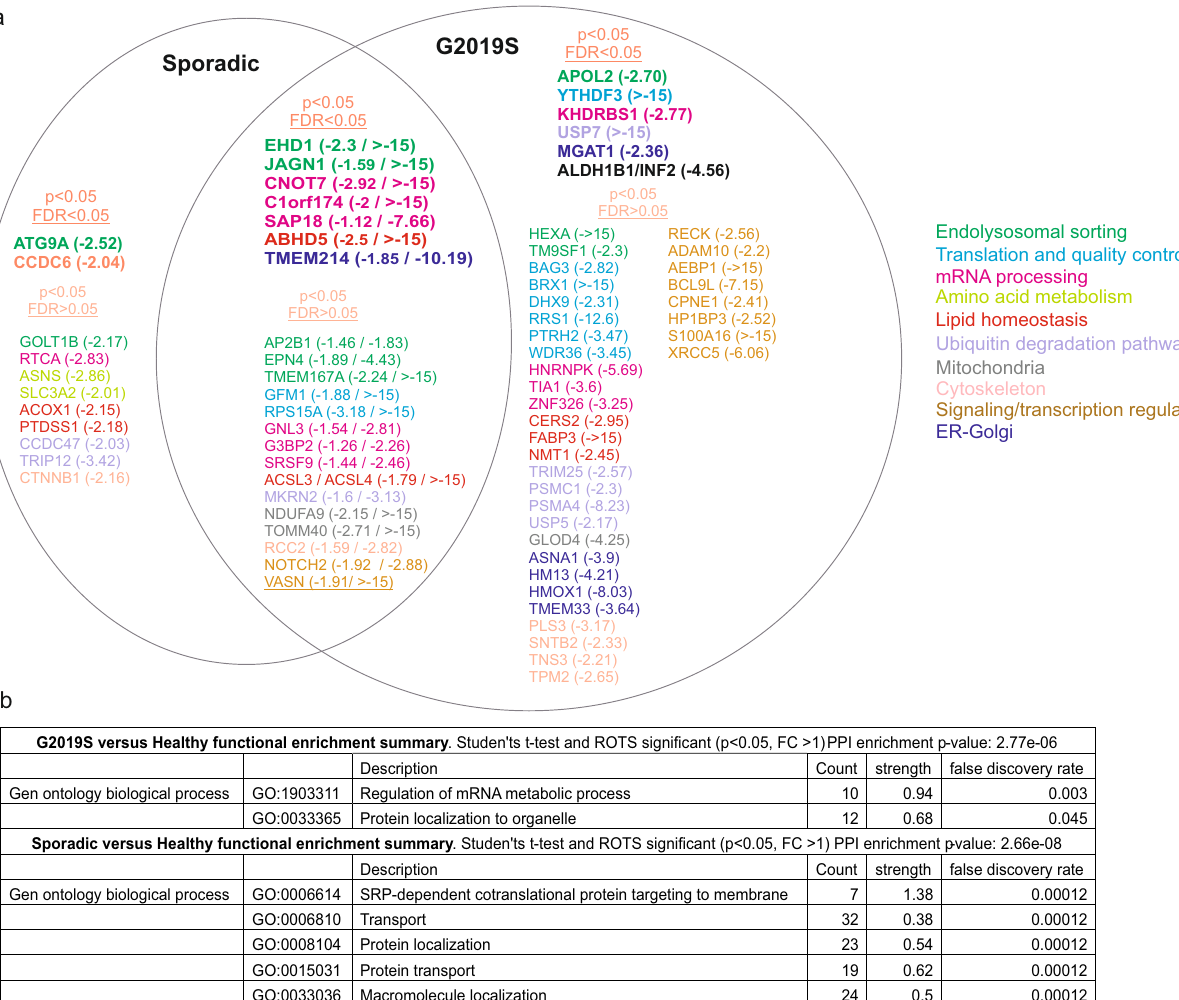
Fig. 5 A. Venn diagram summary of proteins that show reduced homeostasis in LRRK2-G2019S and sporadic PD patients. a Proteins (indicated by gene names) are grouped according to signi fi cance. For each group comparison, proteins that have a fold change >1.5 and a P < 0.05 and FDR < 0.05 in either ROTS or t -test are shown in a separate category to proteins with p < 0.05 but FDR > 0.05 in either test. Proteins plotted in the overlap region are signi fi cantly changing in both sporadic and LRRK2-G2019S groups, where FDR < 0.05 in either ROTS or t-test in either group and p -value < 0.05 in the other group. b STRING enrichment analysis of the proteins shown in a . according to LRRK2-G2019S and sporadic patient groups. Functional enrichments for biological process, local network clusters and KEGG pathways are shown. Input data is from the union of ROTS and t -test PRM analysis changes ( p < 0.05 and FC > 1). Strength is calculated from log10(observed/expected) network proteins. FDR values show p -values corrected for multiple testing using the Benjamini-Hochberg